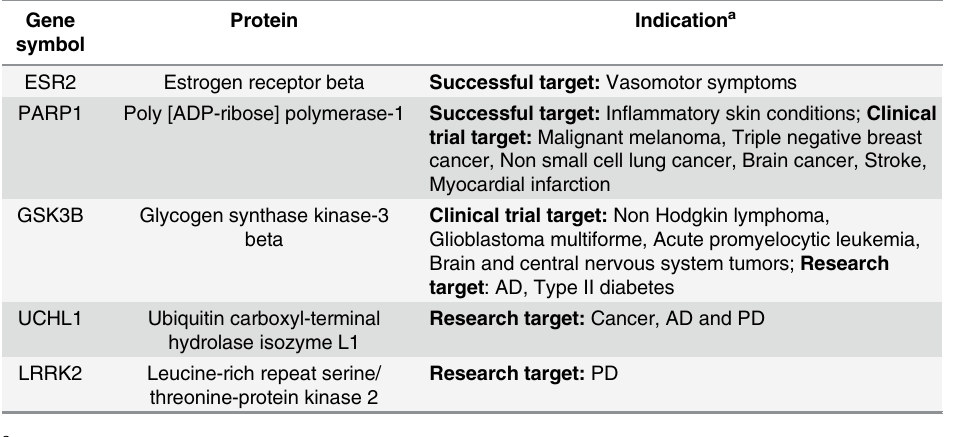
Table 2. Indications of common susceptibility genes of AD, PD and